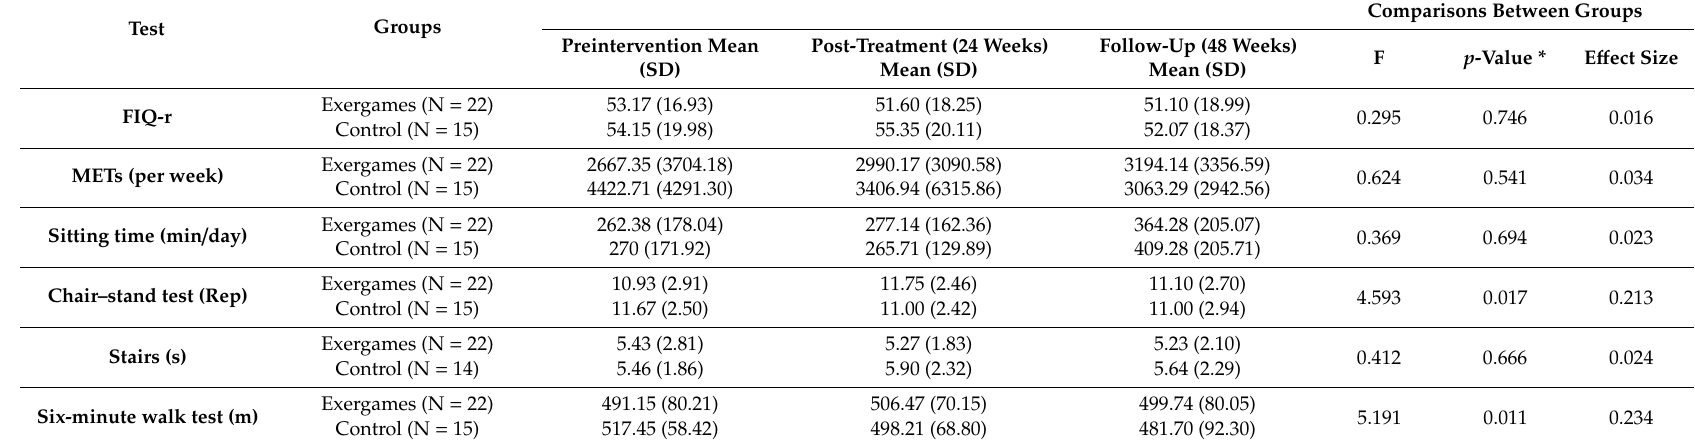
Table 2. E ff ects of an exergame intervention in women with fibromyalgia on lower-body strength, agility, and cardiorespiratory